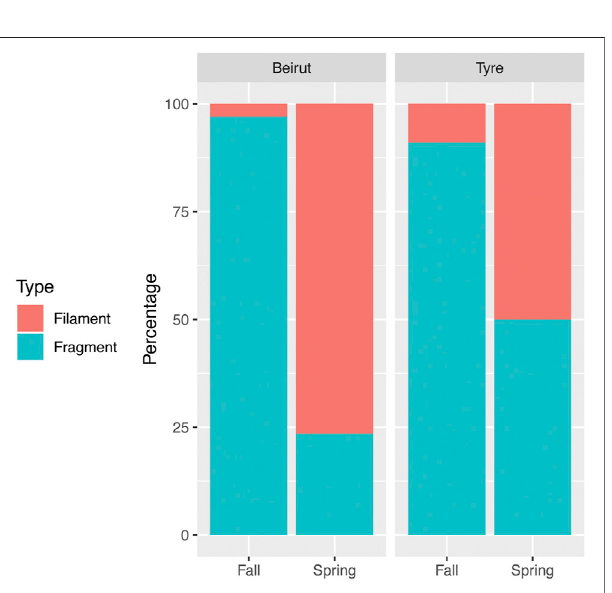
Frontiers in Environmental Science |